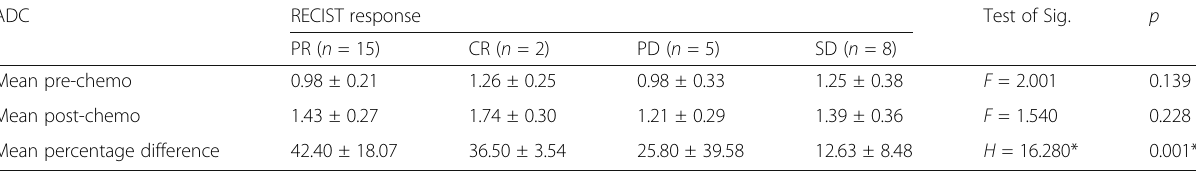
Table 4 Relation between RECIST response and mean pre-, post-chemotherapy ADC, and % difference of ADC ( n = 30) ADC RECIST response Test of